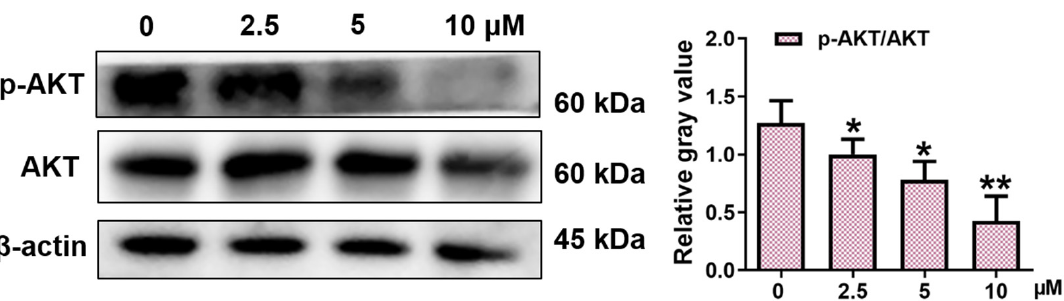
Figure 5. Effect of compound B5 on Akt protein at the cell level. HepG2 cells were pretreated with compound B5 (0, 2.5, 5, 10 µ M) for 48 h, cell lysates were prepared and analyzed for the phosphorylation state of the Akt kinase via Western blot. Data are represented by the mean ± SD of the three independent experiments. ** p < 0.01, * p < 0.05, compared with the 0 µ M group.